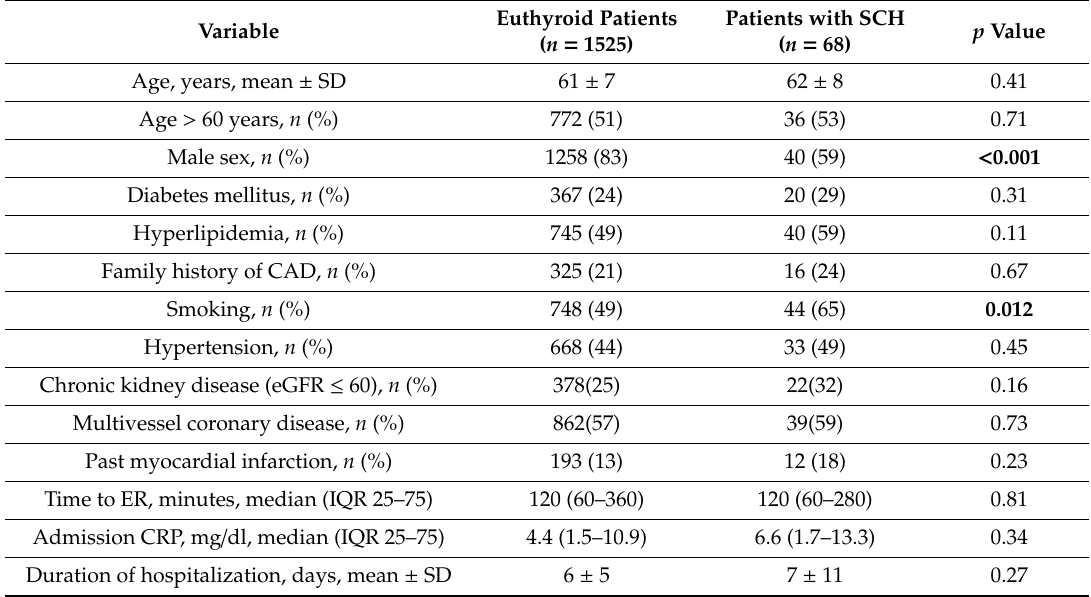
Table1. Baselinecriteriaof1593STEMIpatientsaccordingtothepresenceofsubclinicalhypothyroidism.